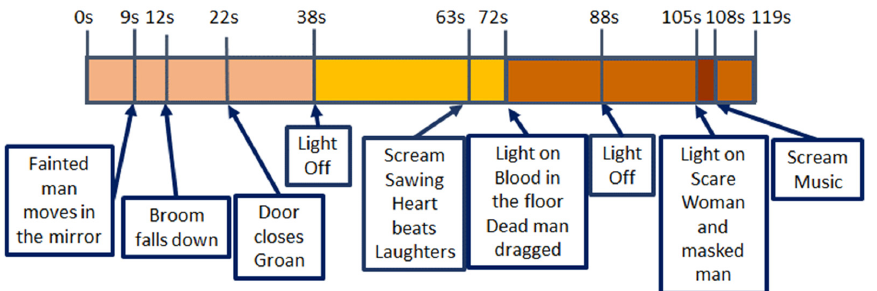
Figure 13. V04 main stressful events. “Chamber of horrors” Inside 360 VR Prod 2018. Available at [62].